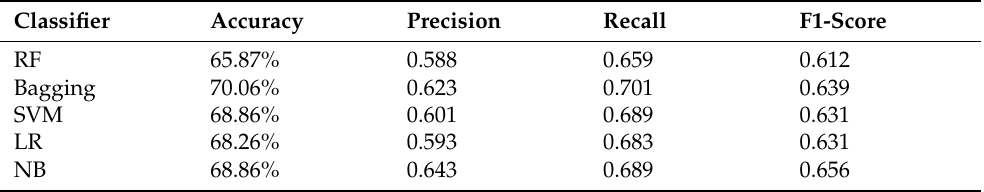
Table 23. Experiments with ML models and AFINN + MPQA lexicons on the TextBlob sentiments.